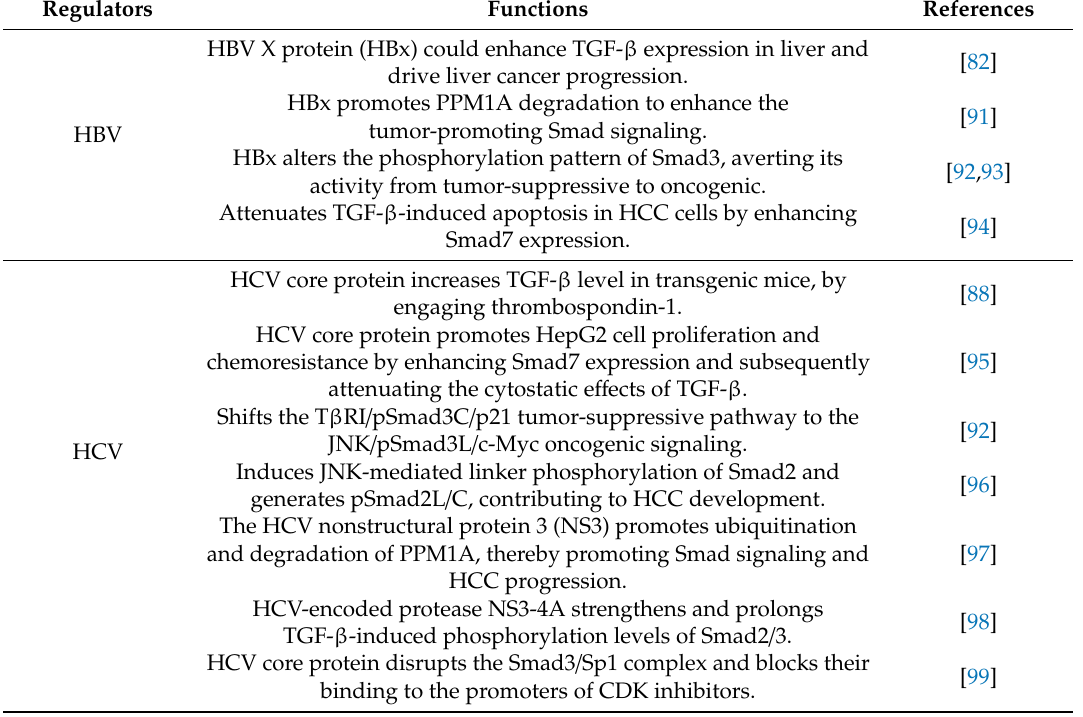
Table 1. E ff ects of HBV and HCV on TGF- β / Smad